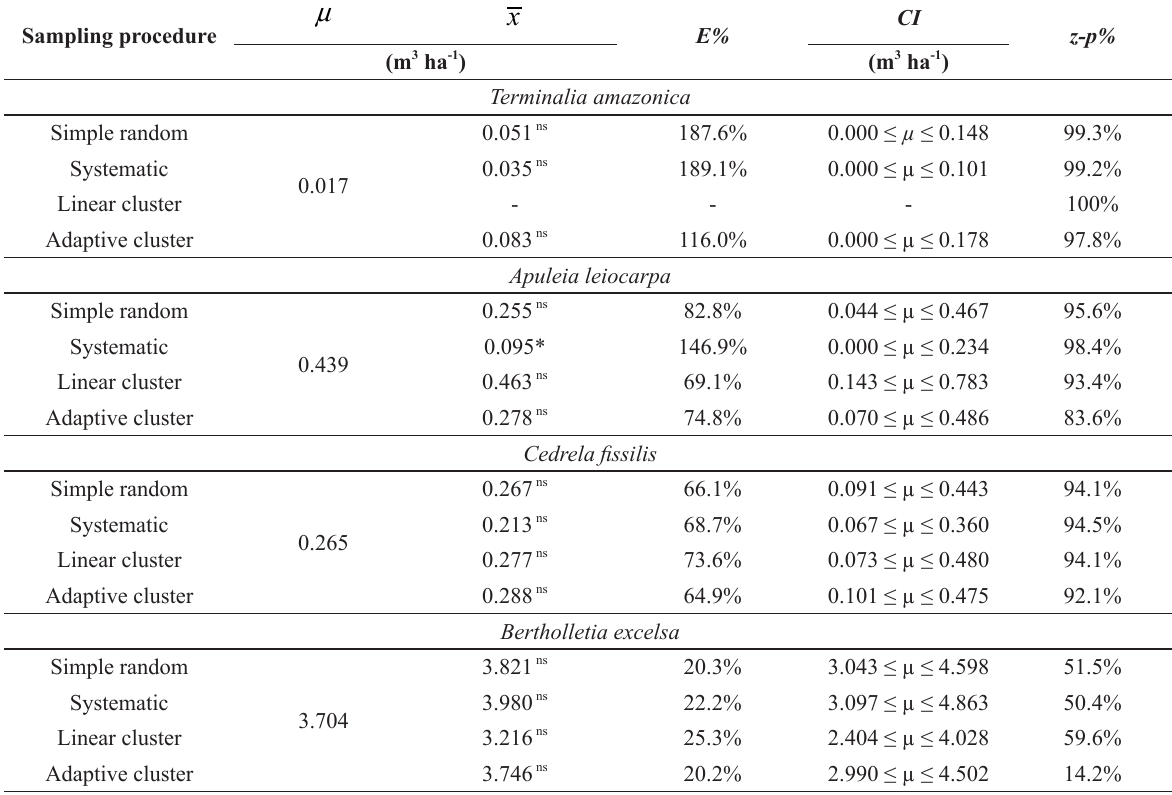
Commercial volume estimation and percentage of zero-plots by sampling procedures in Jamari National Forest, Brazilian